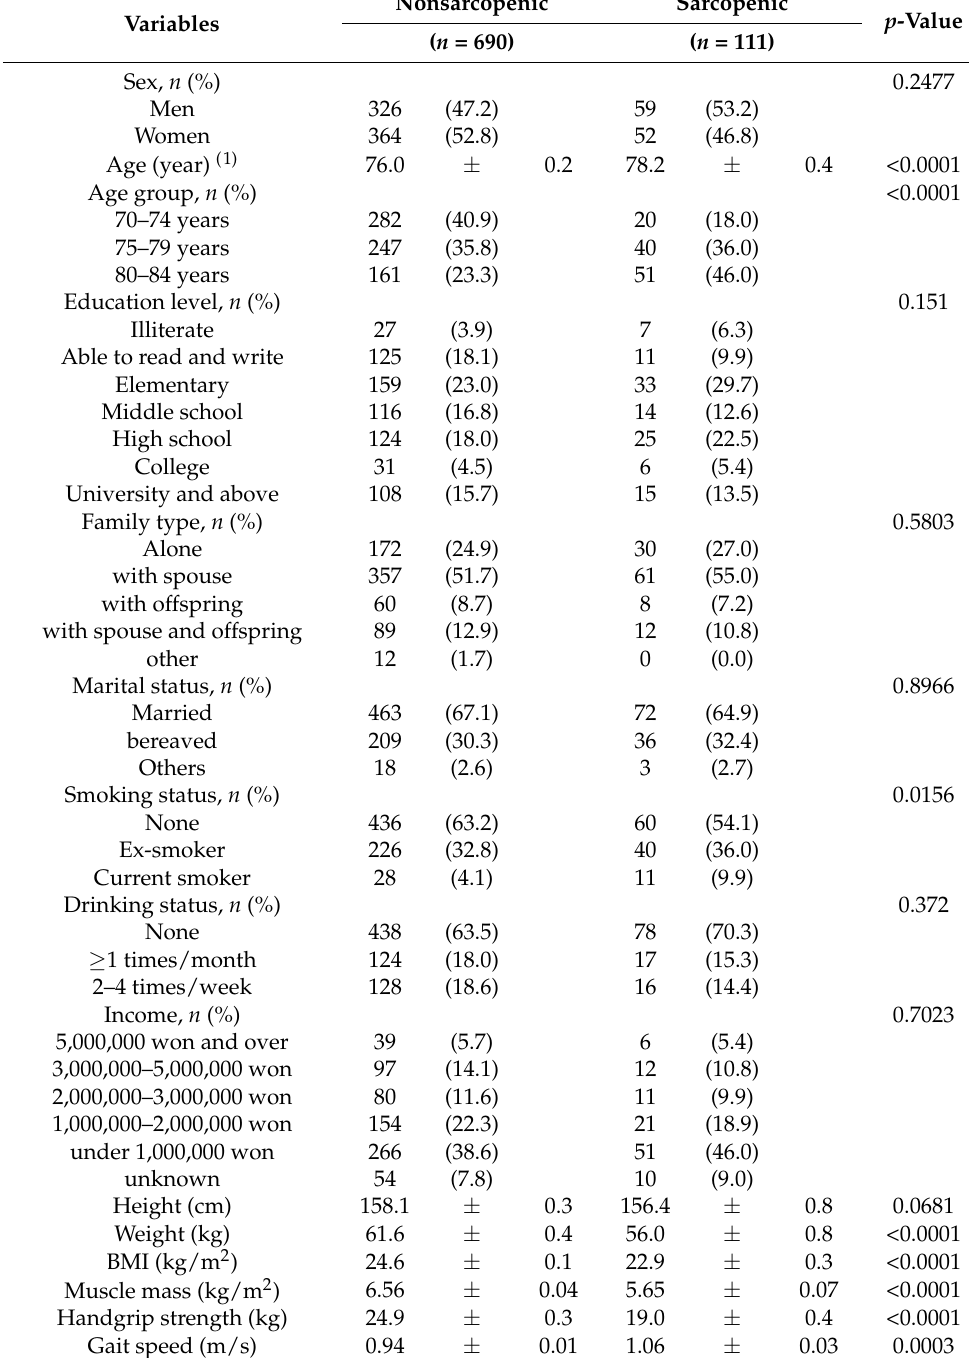
Table 1. The characteristics of the